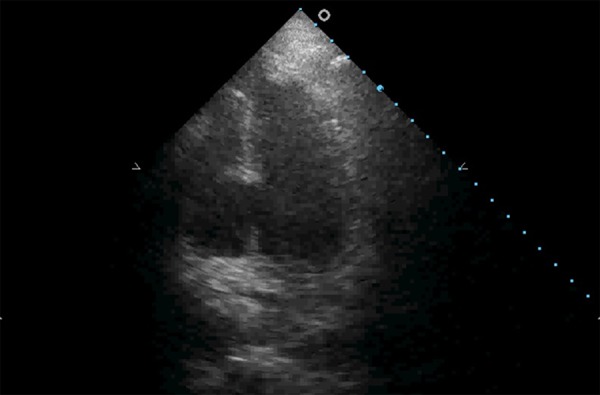
Interventricular septum rupture under acute inferior wall myocardial
infarction.